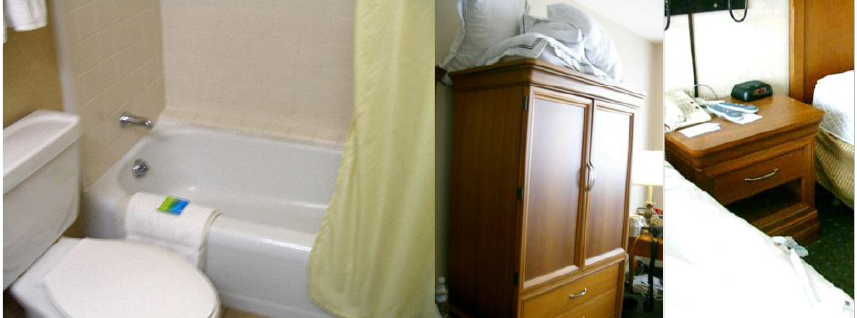
Figure 1. Room layout used for study data collection.